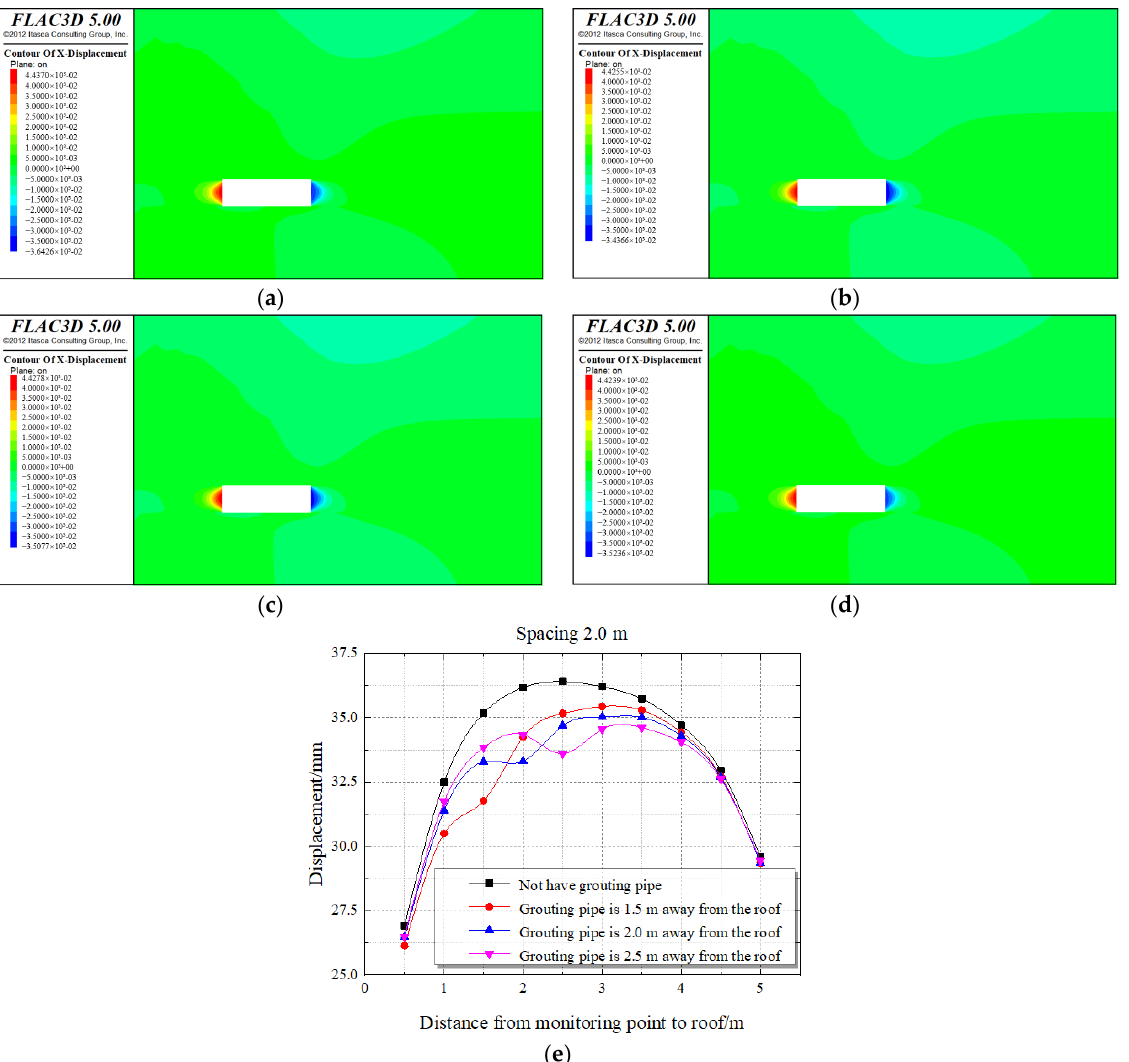
as shown in Figure 15.